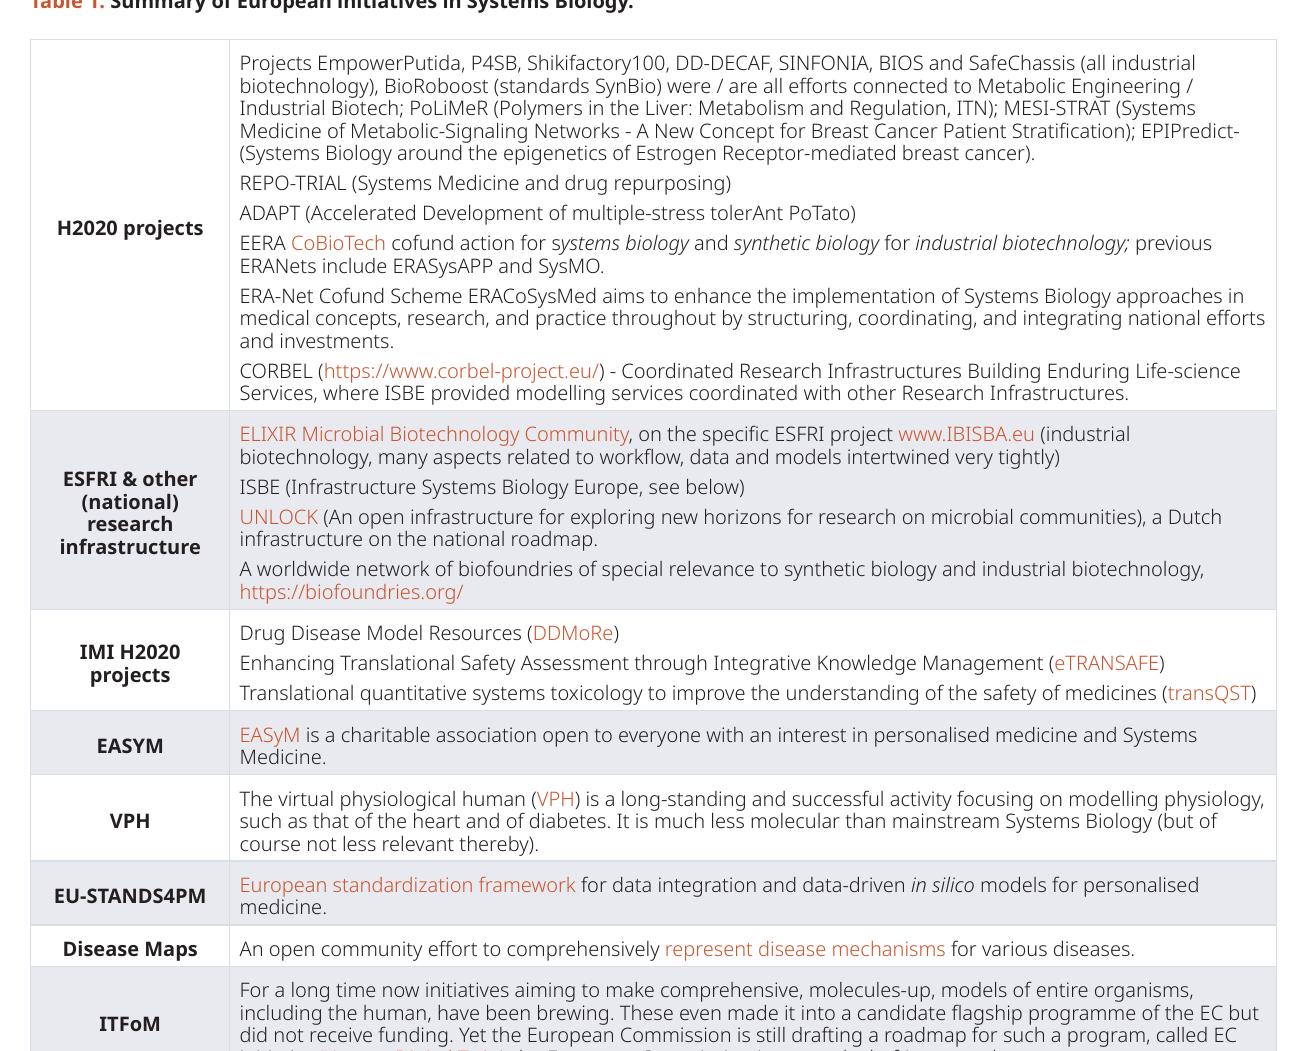
Table 1. Summary of European initiatives in Systems Biology.